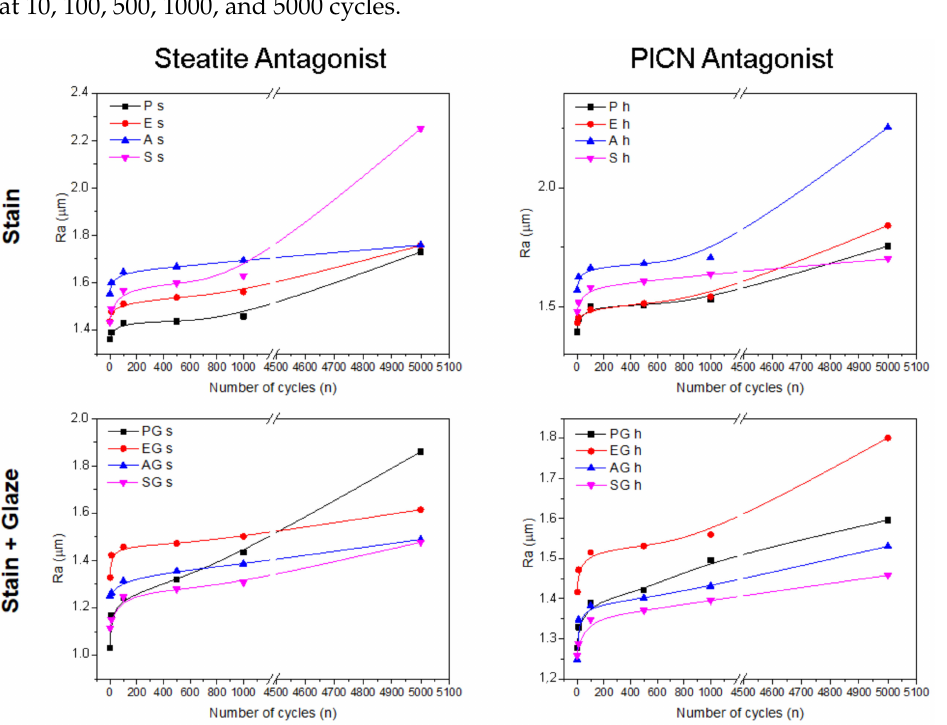
Figure 2. Line graphs showing the average roughness (Ra) of each experimental group at the established